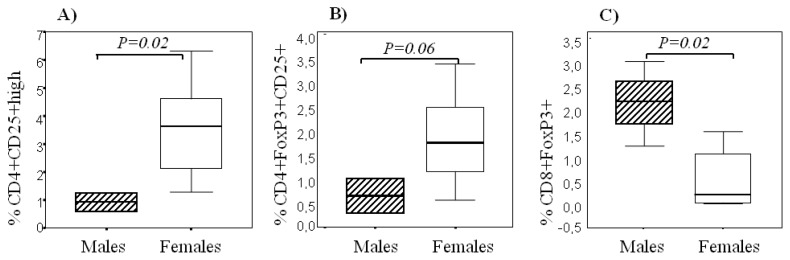
Sexual dimorphism in regulatory T cells in the cerebrospinal fluid (CSF) of MS patients with first clinical isolated syndrome (CIS). (A) CD4+ TReg, defined as CD4+CD25hi+, frequencies in the CSF of men and women with CIS; (B) CD4+ TReg, defined as CD4+FoxP3+CD25+; and (C) CD8+ TReg, defined as CD8+ FoxP3+, frequencies in the CSF of men and women with CIS.